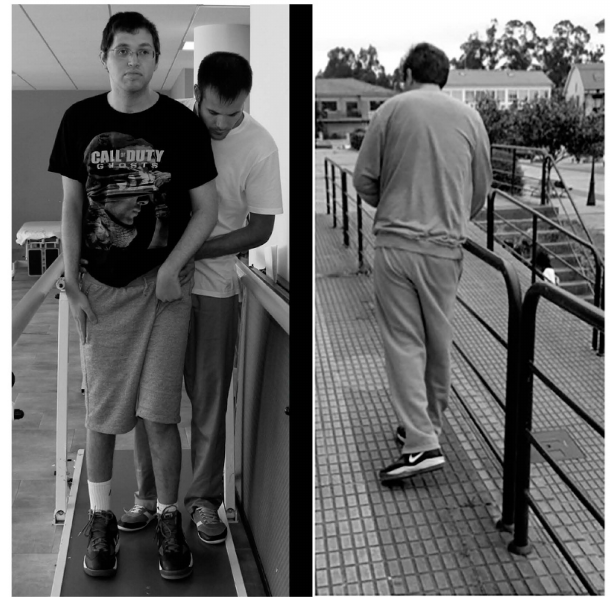
Figure 4. Working and walking after the feet surgery: ( Left ) the patient beginning to walk in parallel bars with the help of a physiotherapist and ( Right ) the patient beginning to walk alone on the street. Observe the movement of his left foot and leg.